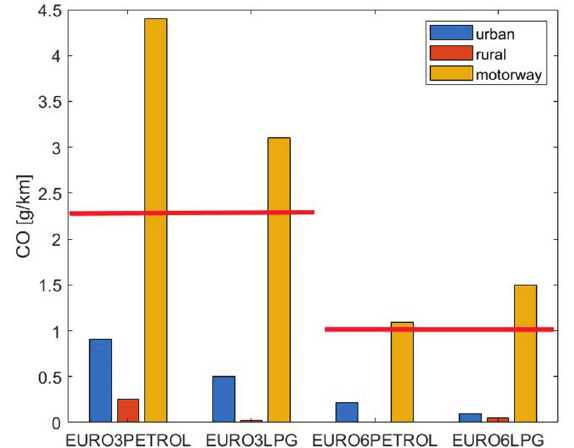
Fig, 14. Correlation between NO x emission intensity and velocity and acceleration of Euro 6 LPG fuelled vehicle